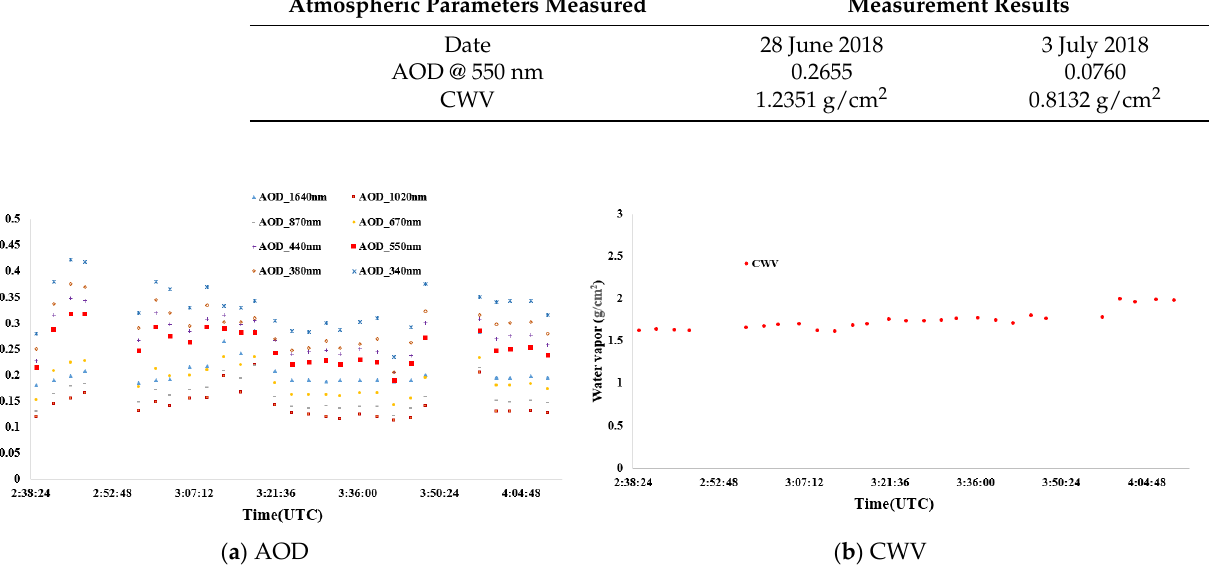
Figure 5. Synchronous measurements of atmospheric parameters at Baotou site on June 28, 2018.